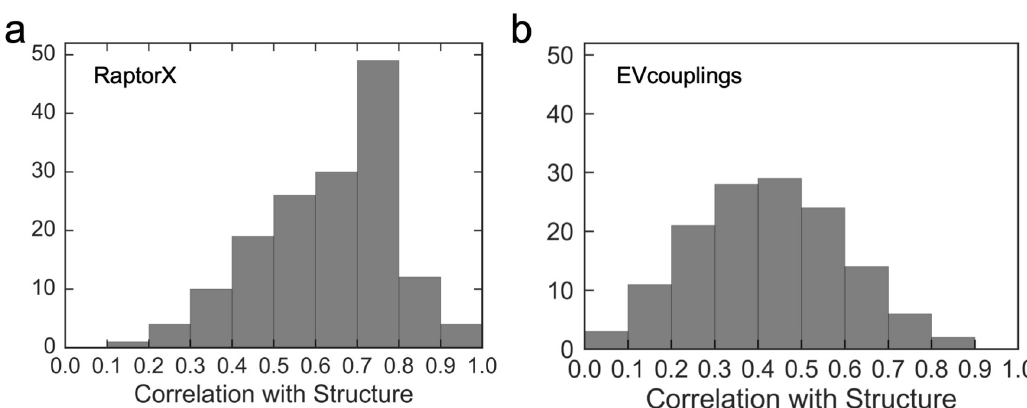
Fig 5. Distribution of correlation coefficients. The distribution of correlation coefficients between B-factors from Seq-GNM and GNM from structure. (a) The average correlation coefficient is 0.63 with RaptorX EC values. (b) The average correlation coefficient is 0.43 by using EVcouplings EC values.